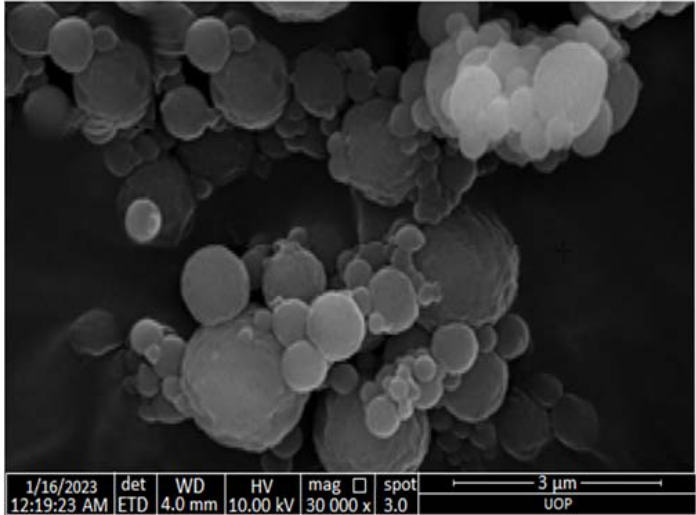
Figure 3. SEM image of SNPs synthesized from leaf extract of Citrus limon.